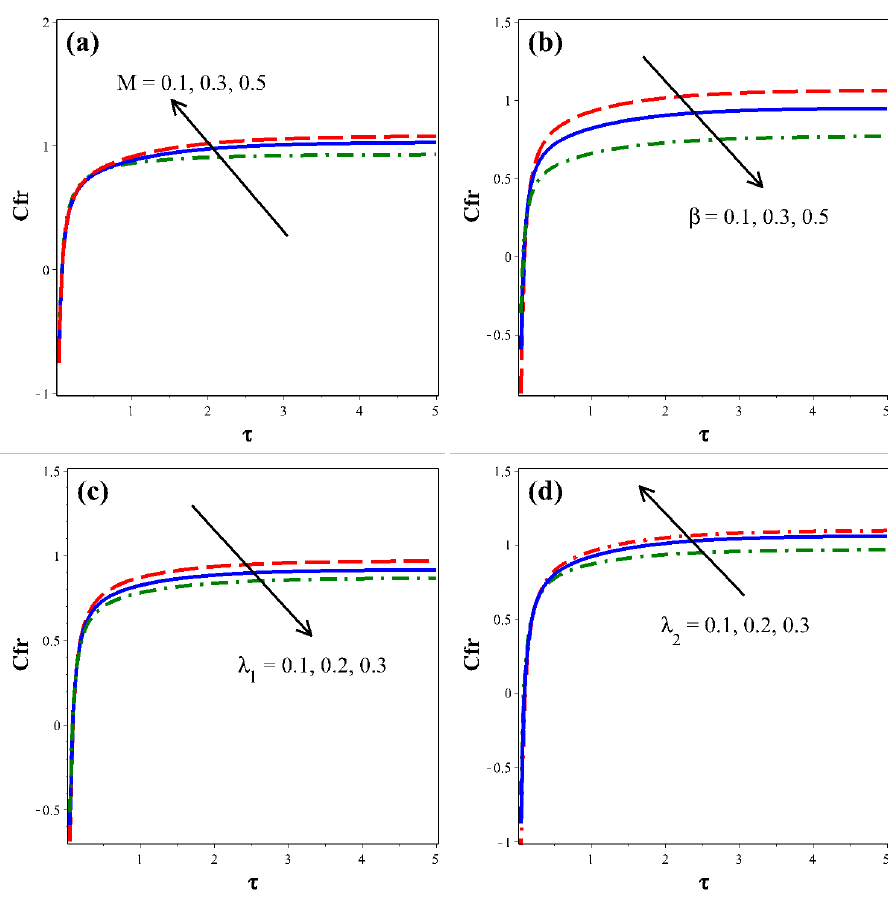
Fig. 4: Influence of magnetic parameter, stagnation parameter, first and second order slip velocities parameters on skin friction coefficient. ter heats the boundary layer and reduces temperature gra- dient at the wall, to which N is S